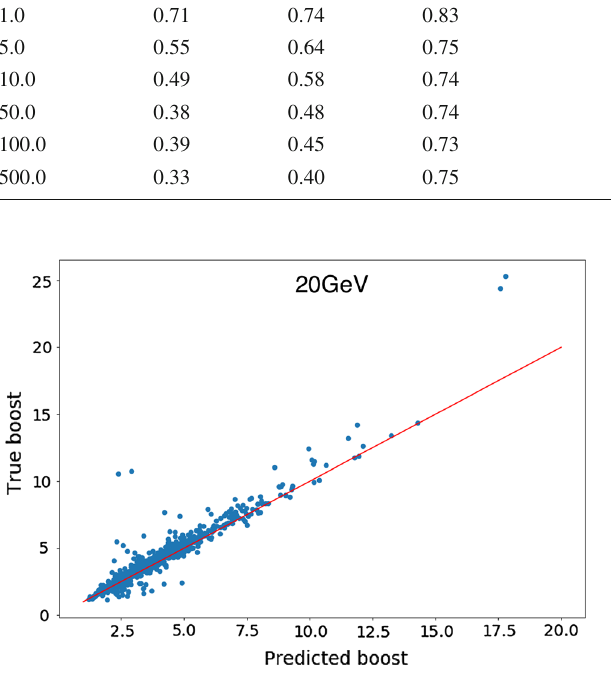
Fig. 32 Six-body boost reconstruction for a narrow 20 GeV resonance decay into ττ with τ − → π − π − π +